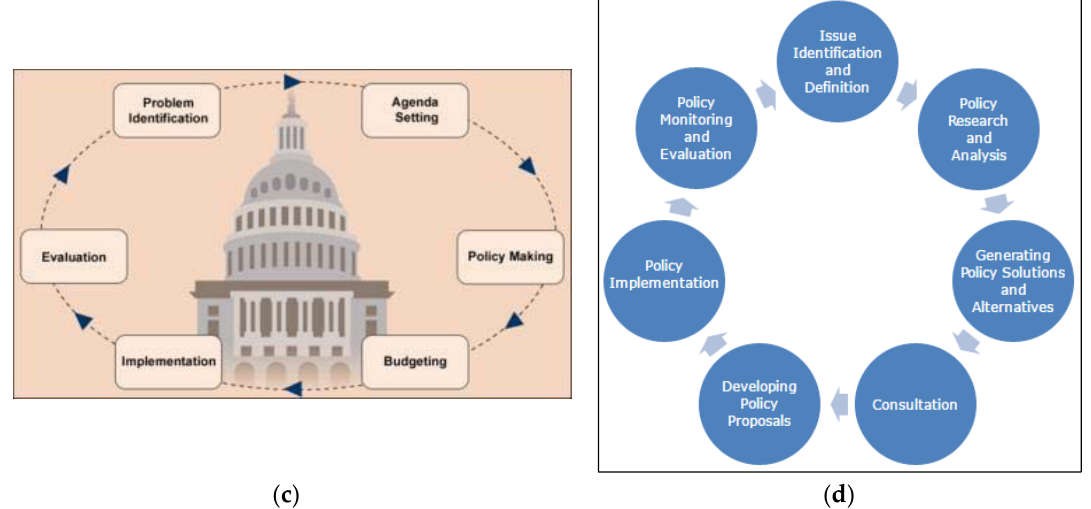
Figure 2. Policy Cycles: ( a ) Australia [19]; ( b ) United Kingdom [26]; ( c ) United Stated of America [27]; and ( d ) Newfoundland and Labrador, Canada [28].